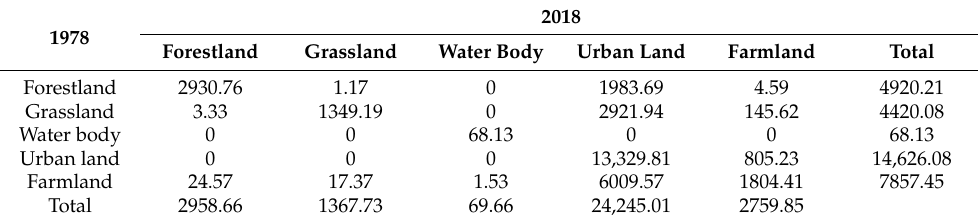
Table 2. Transition matrix of land use/cover from 1978 to 2018 in the built-up area of Guiyang (ha).